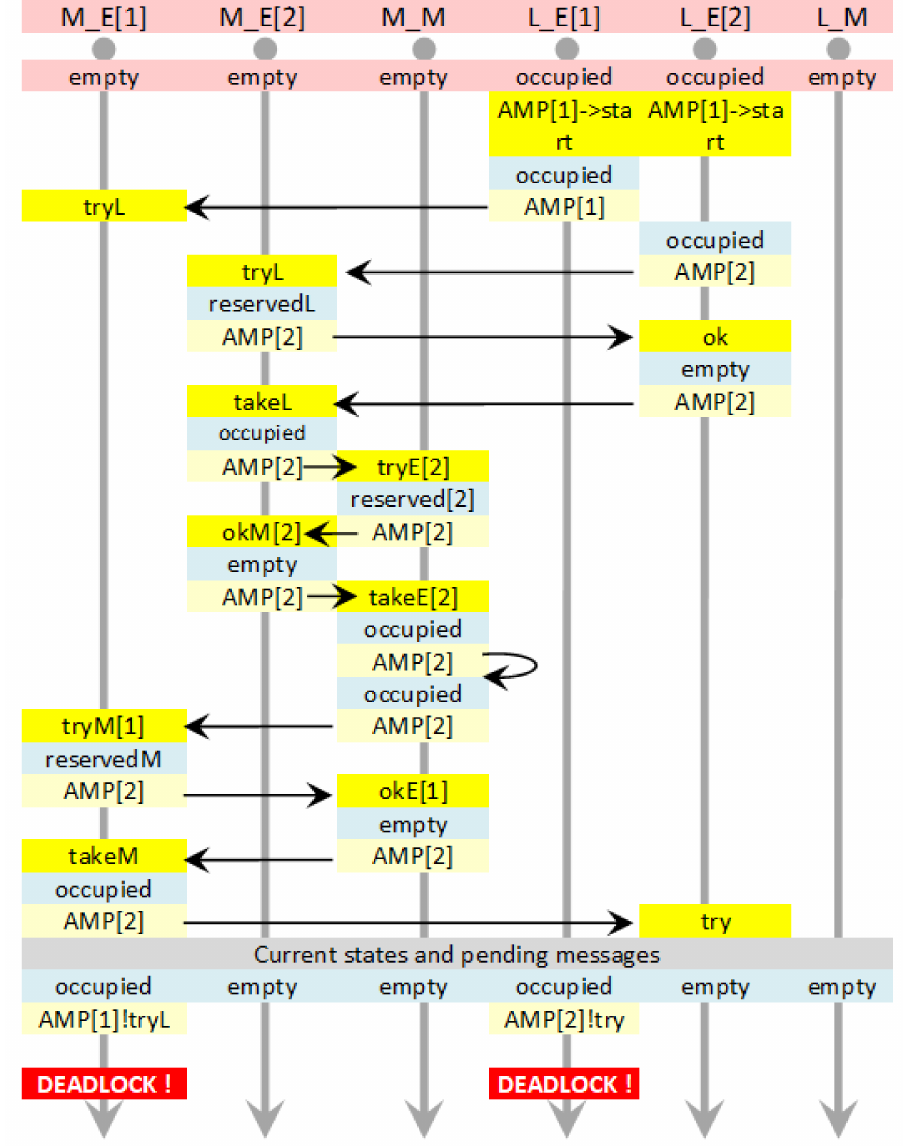
Figure 12. Communication structure in a trace of the timeless AMP’s behavior, leading to a